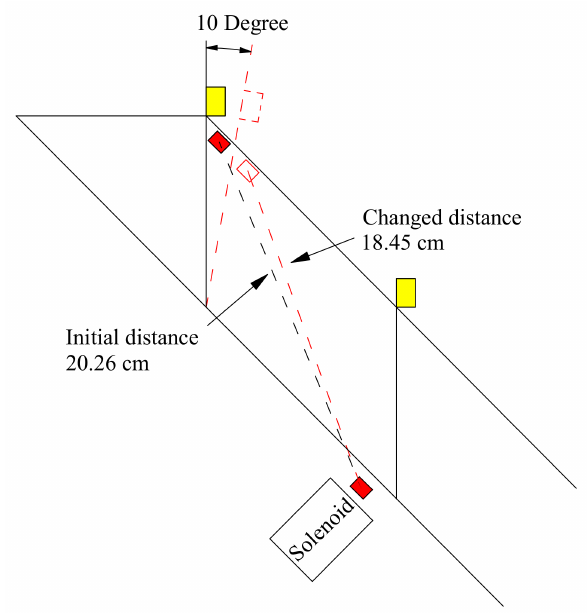
Figure 14. Schematic illustration of the movement of wave receivers and changed